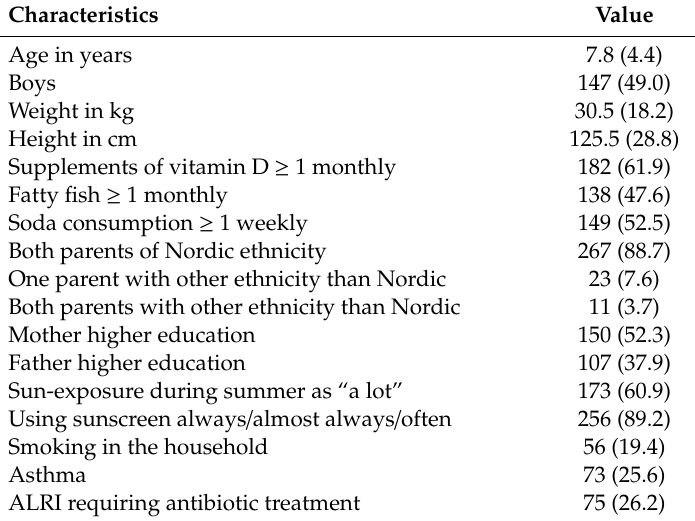
Table 1. Child characteristics.